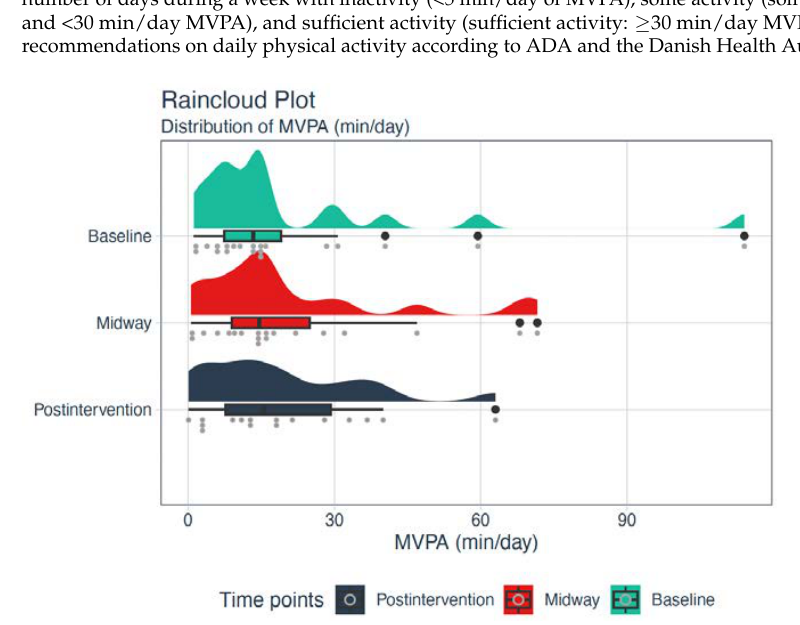
Figure 3. Raincloud plot representing an illustration of data in a half-density distribution (the ‘cloud’) with individual raw data (the ‘rain’) and a boxplot below the ‘cloud’ of the total daily moderate to vigorous physical activity (MVPA) in minutes at baseline, midway, and post-intervention.